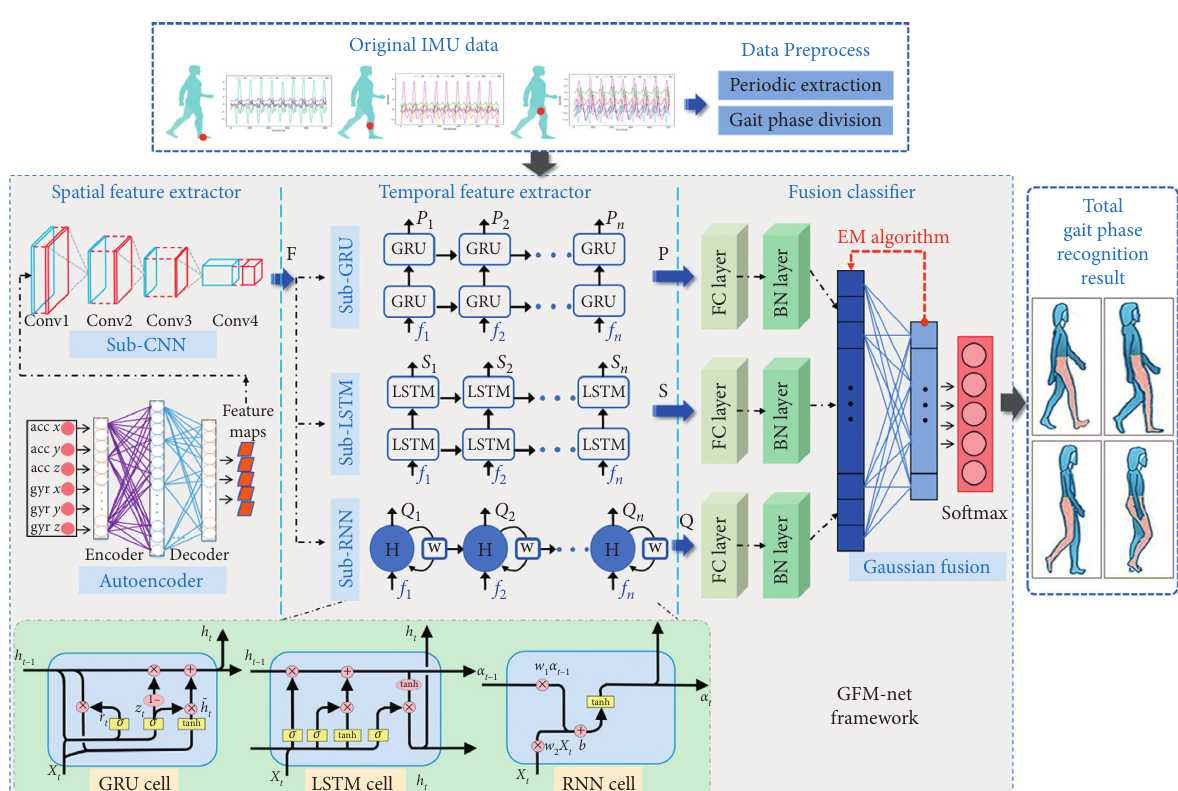
Figure 6: The proposed architecture of GFM-Net framework for gait phase